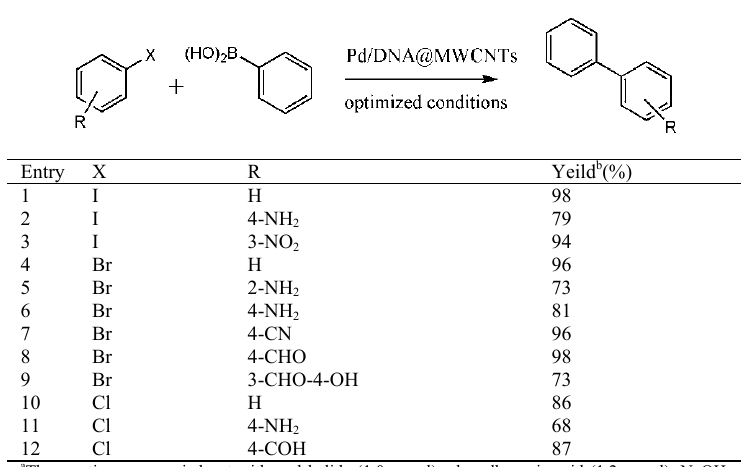
Table 2. Suzuki cross-coupling of various aryl halides in the presence of the catalyst. a